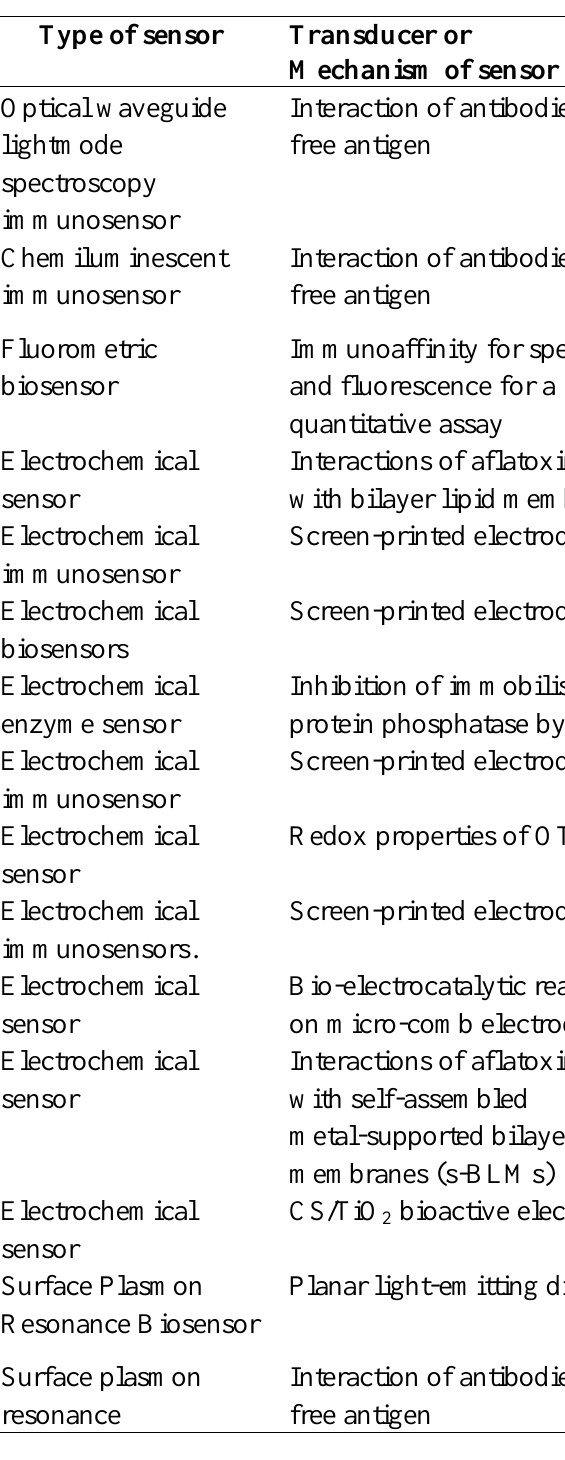
Table 1. Immunosensors for the determination of small molecule biological toxins in the past